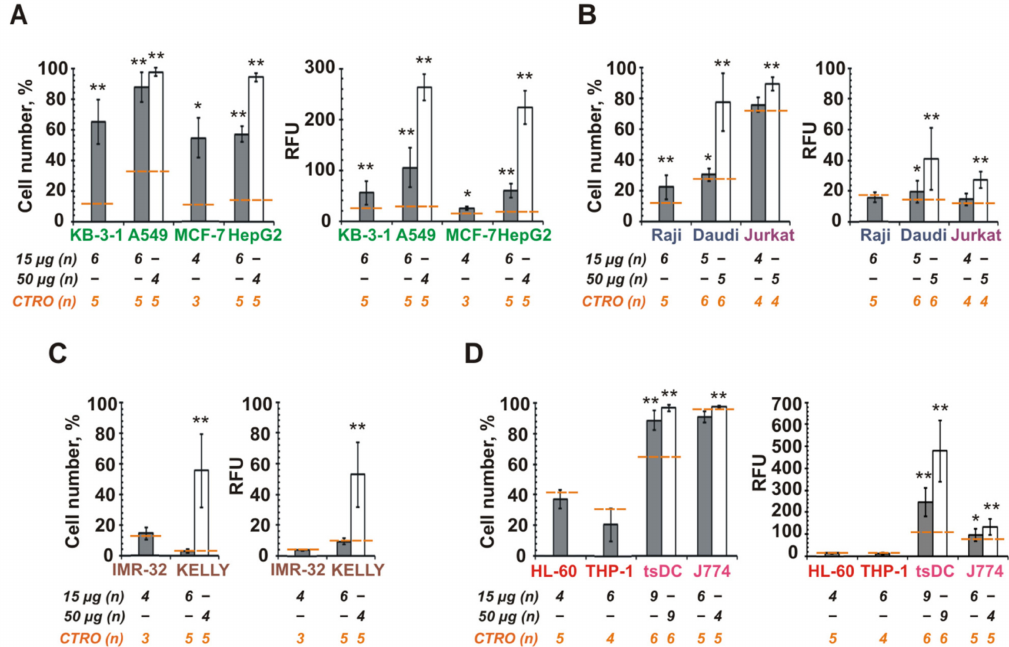
Figure 3. FAM-ON accumulation in mammalian cells mediated by MSC CINVs. Fifteen micrograms (grey bars) or 50 µ g (white bars) FAM-ON loaded MSC CINVs were incubated with: ( A )–Epithelial cancer cells; ( B )–Lymphoid cancer cells; ( C )–Human neuroblastoma cells; ( D )–Human myeloid cancer cells, mouse tsDCs, and macrophage-like J774 cells. Cell number is the percentage of FAM-positive cells in a population. RFU is relative fluorescence units. The level of FAM-ON self-penetration into the cells (CTRO) is shown by an orange dashed line. The number of measurements is indicated as n . “-“–not determined. Experimental data are presented as the mean ± SD. Statistical analysis was performed using the Mann–Whitney U test and was carried out between the experimental group ( n = 4–9) and CTRO ( n = 3–6); * p ≤ 0.05, ** p ≤